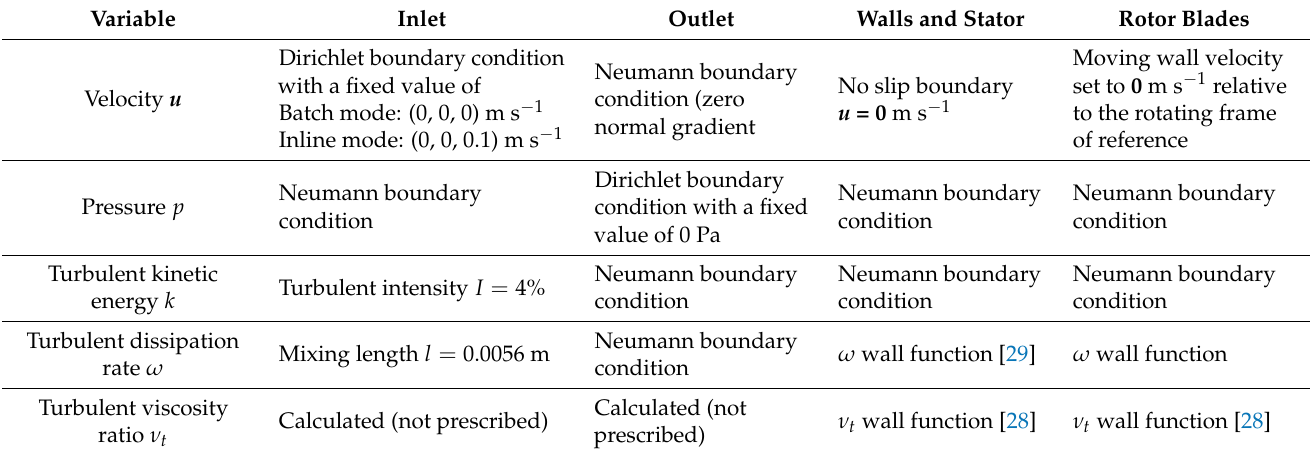
Table 1. Boundary conditions for both batch and inline simulations.